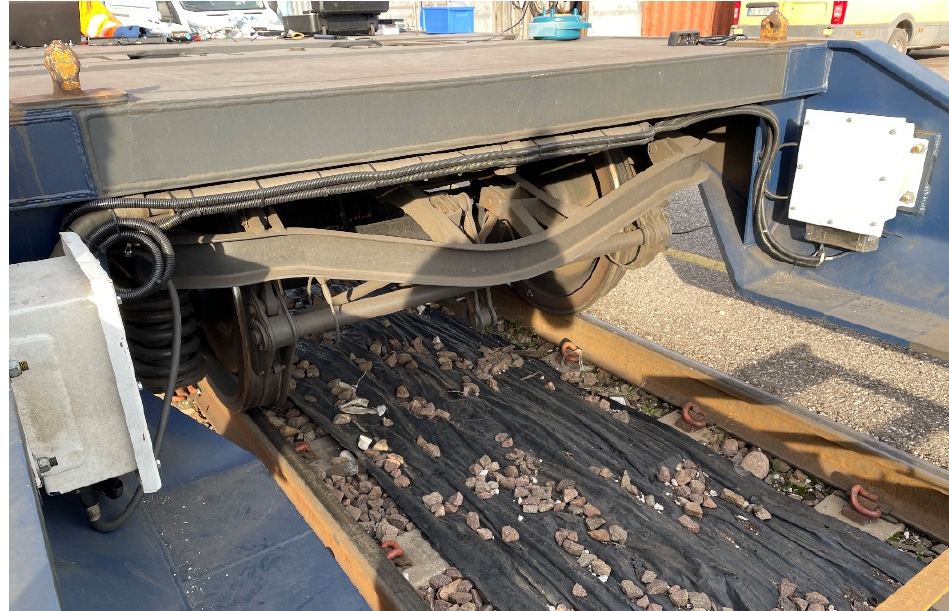
Figure 10. Data collector box on Mercitalia Intermodal wagon.